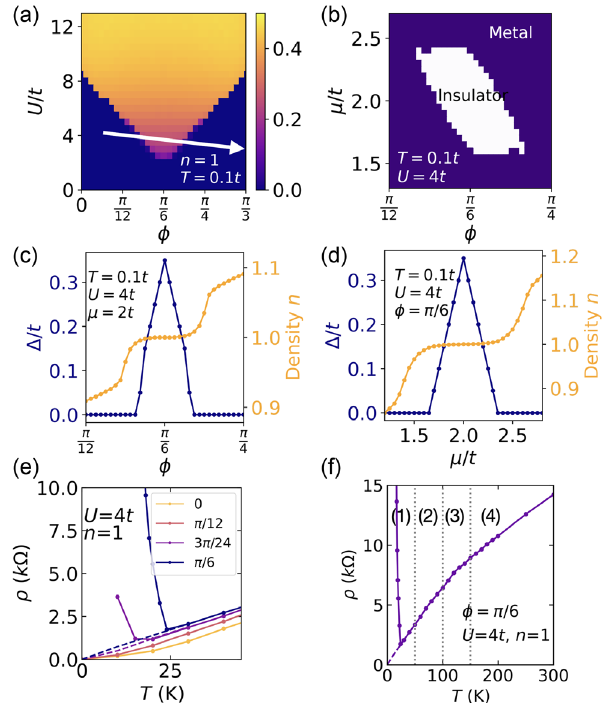
FIG. 8. (a) Magnetization as a function of phase ϕ and interaction U at half filling. The color represents the magneti- zation amplitude. The white arrow shows the parameter space trajectory followed when the displacement field is increased in experiments. (b) Metal-insulator reentrant behavior as a function of chemical potential μ and phase ϕ at U ¼ 4 t . We numerically determine the insulating state: The system is insulating if density remains at half filling ( Δ n < 0 . 01 ) with varied chemical potential and if magnetization m > 0 . 1 . (c) Gap size Δ and density n versus ϕ at μ ¼ 2 t . (d) Gap size Δ and density n versus μ at ϕ ¼ π = 6 . The gap size is extracted from (b), which is the energy difference between μ and the closest band. (e),(f) Resistivity for different phases ϕ at half filling. The dashed line shows the resistivity computed in the paramagnetic state. In the figure, we choose t ¼ 100 K. In (f), we mark four regions that are explained in the main